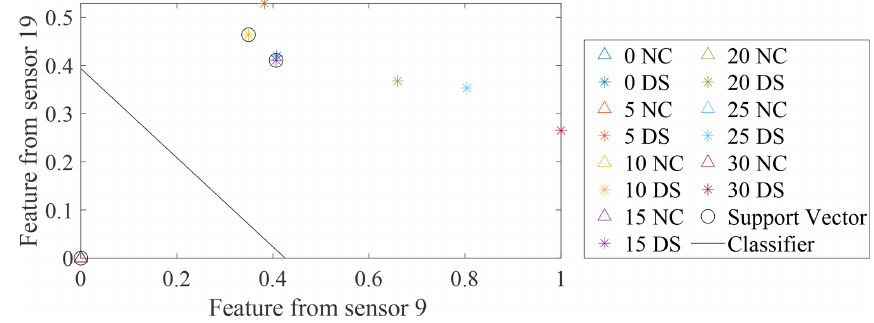
Figure 10. Distribution of MSD-based features from two optimal sensors selected by the SVM optimisation technique. (cid:52) refers to the normal condition and ∗ refers to the damaged state.